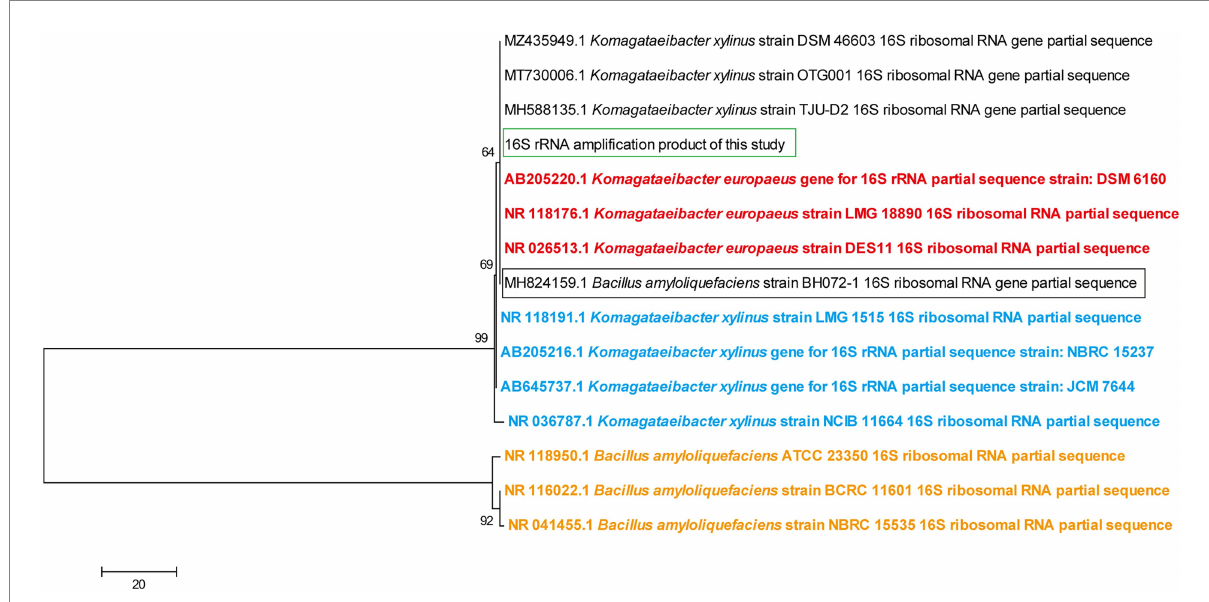
FIGURE 2 Neighbor-Joining phylogenic tree based on 16S rRNA sequences of relavant strains. Sequences from type strains of Komagataeibacter europaeus , Komagataeibacter xylinus , and Bacillus amyloliquefaciens were shown in red, blue, and orange font, respectively. 16S rRNA sequence that was